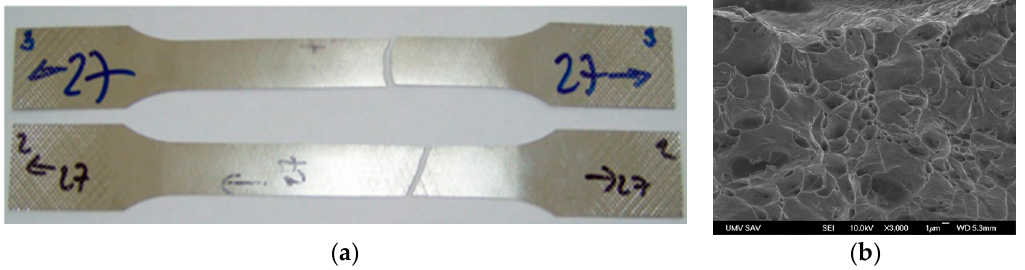
Figure 5. Sample No. 27 ( a ) uniaxial tensile test; ( b ) detail of a fracture of the specimen.